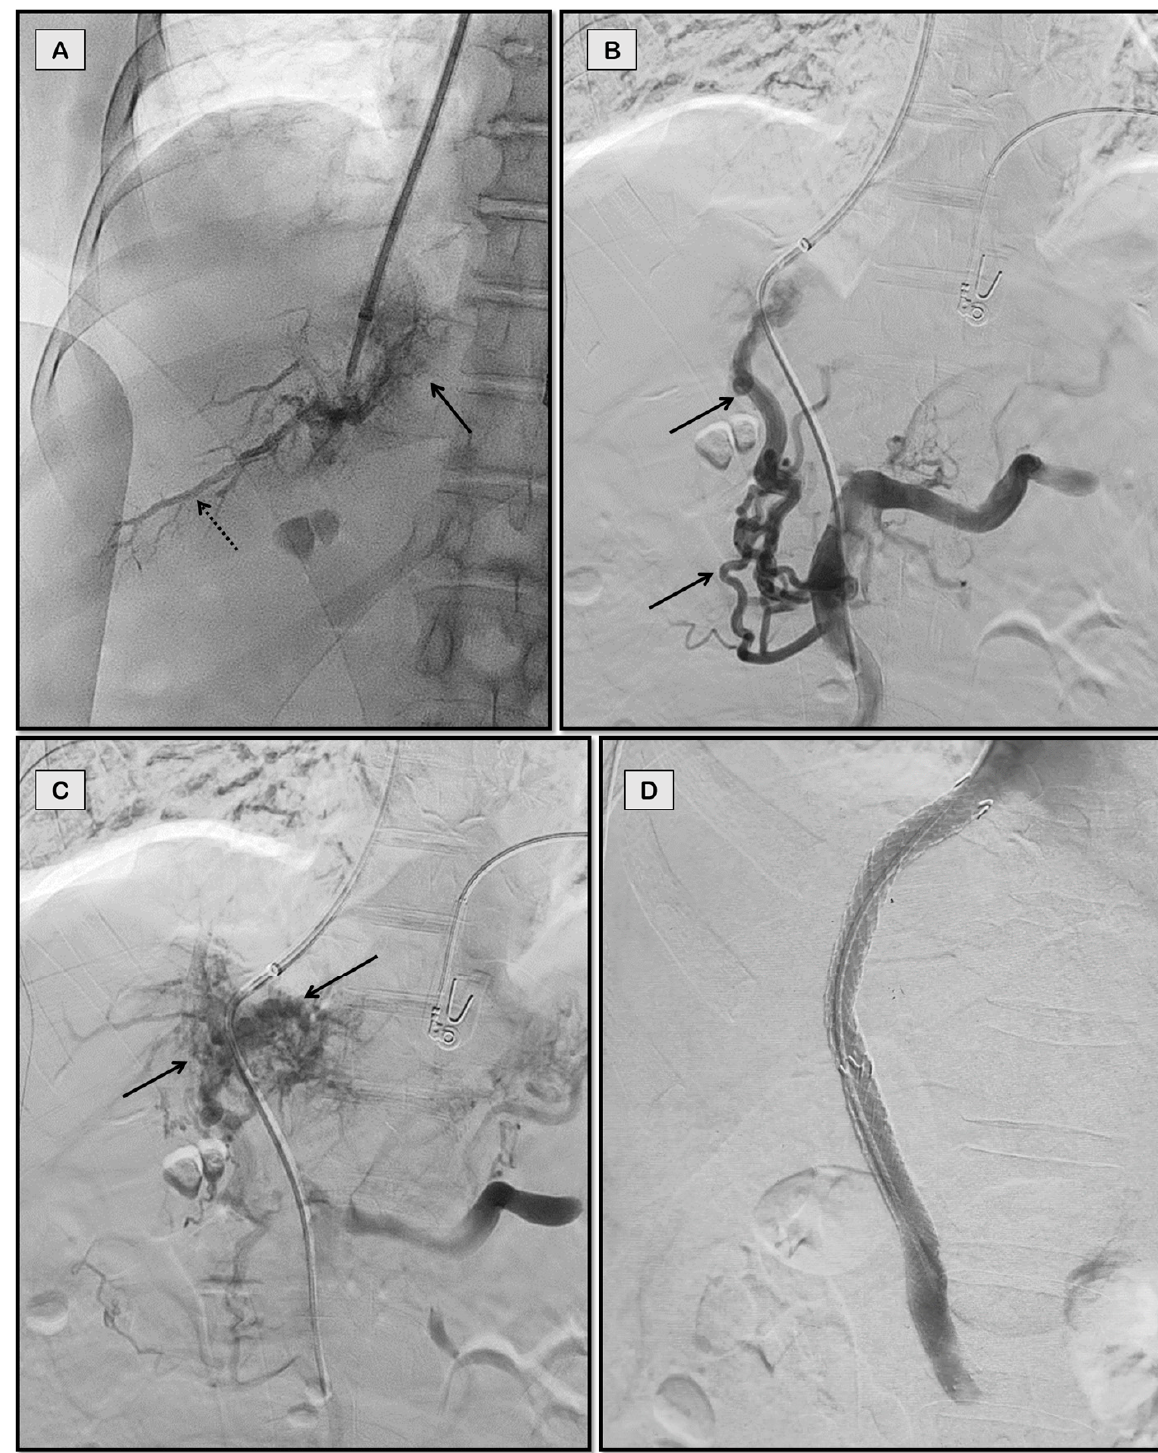
Figure 2. TIPS for recurrent variceal bleeding in a 63-year-old woman with chronic non-cirrhotic portal vein thrombosis. Fluoroscopic spot image ( A ) shows the partially thrombosed posterior segmental branch of right portal vein (dashed arrow) accessed through jugular approach. Abnormal parenchymal blush is also noted (solid arrow) signifying poor inflow to liver. Superior mesenteric vein angiogram ( B , C ) showed completely thrombosed portal vein with multiple periportal collaterals (arrows in B ) and portal cavernoma (arrows in C ). Brisk flow was noted post-stenting ( D ).